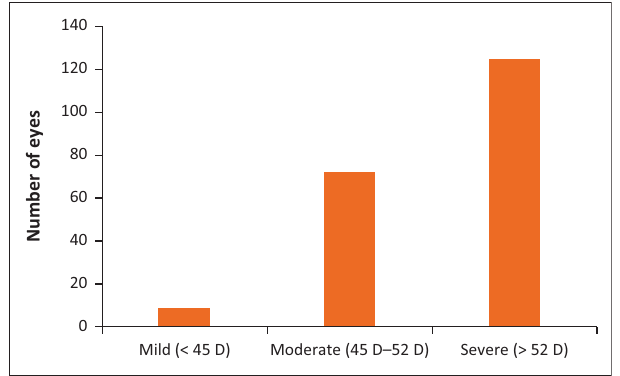
FIG URE 3: Bar graph indicating the severity of keratoconus for 206 patients at the University of Johannesburg contact lens clinic, seen between 2007 and